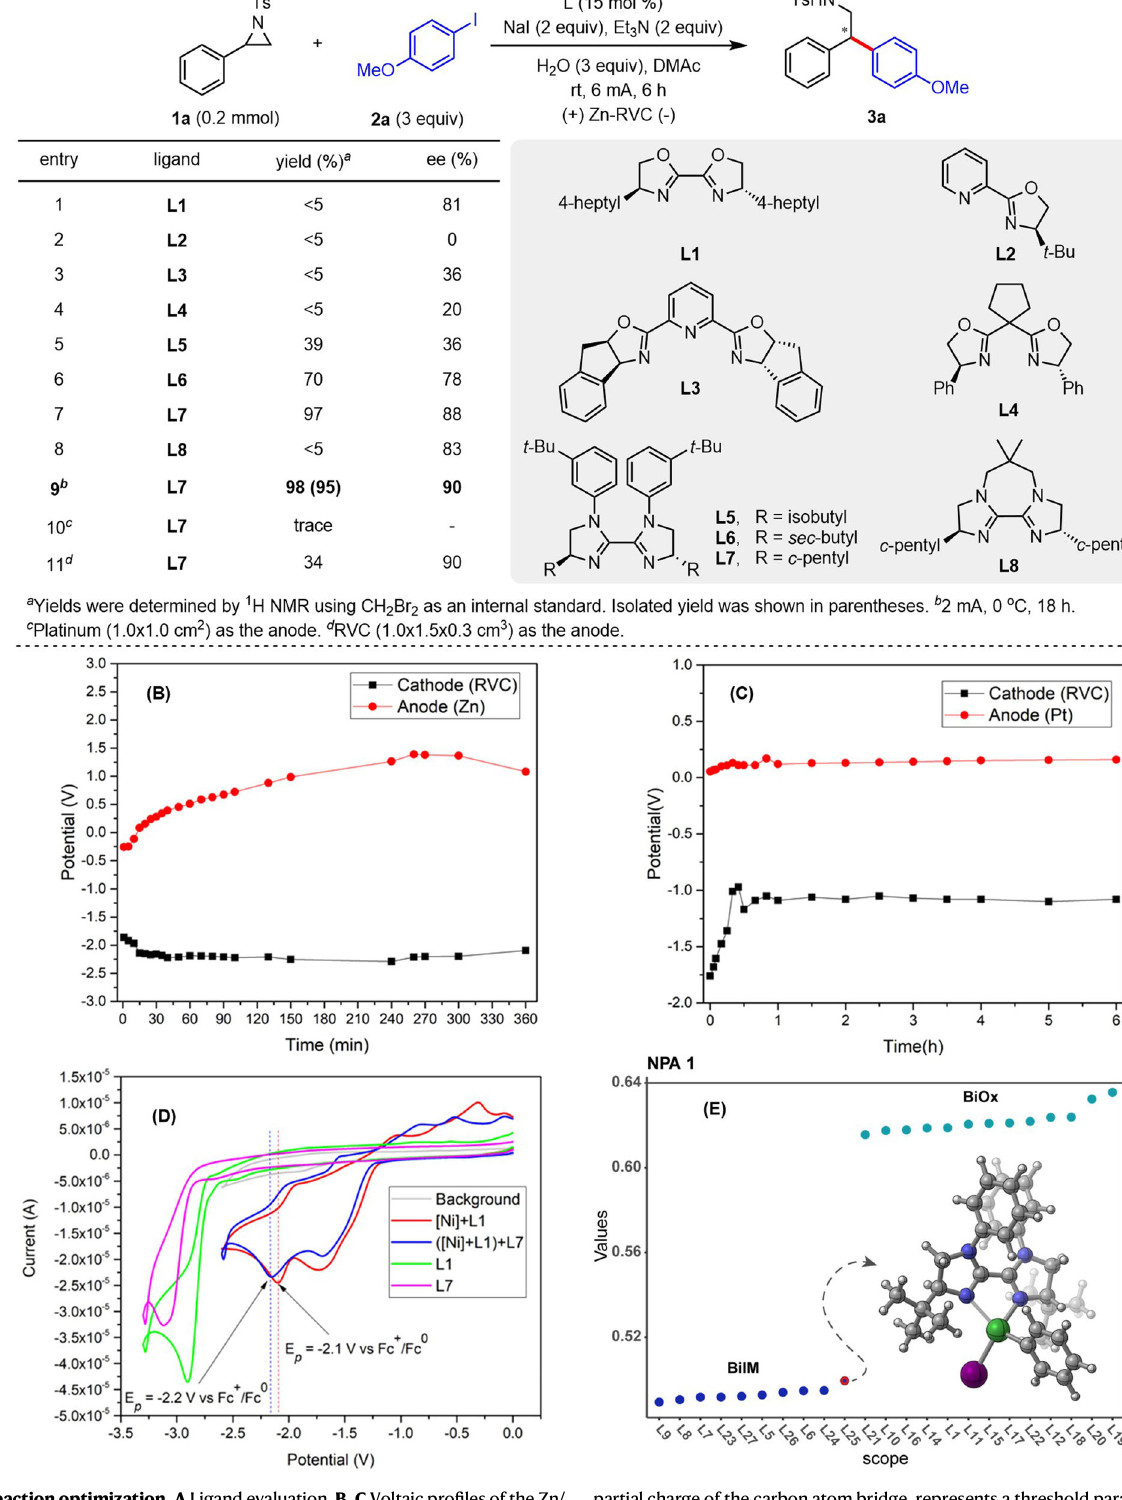
partialchargeofthecarbonatombridge,representsathreshold parameterableto distinguish between the BiIM and BiOx ligands. The y axis represents the values of NPA 1 and the x axis is the scope of ligands